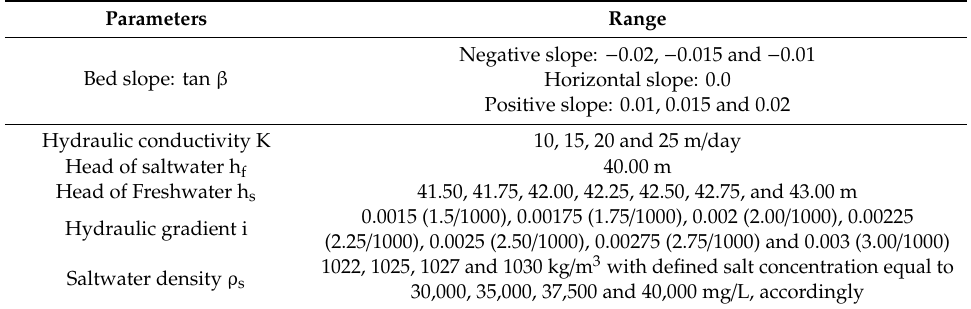
Table 3. Tested numerical simulation range of hydraulic parameters to test the e ff ect on saltwater intrusion (SWI) length.